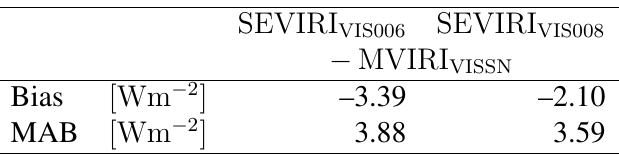
Table 2 quantifies the differences between the solar surface irradiance derived from MVIRI broadband channel and the SEVIRI channels VIS006 and VIS008 as bias and mean absolute bias (MAB). The MAB between the solar surface irradiance derived from the two instruments is below 4 Wm − 2 for both SEVIRI channels. On average, both SEVIRI channels yield a lower solar surface irradiance than the broadband VIS channel of the MVIRI instrument. While the use of the VIS006 SEVIRI channel always results in